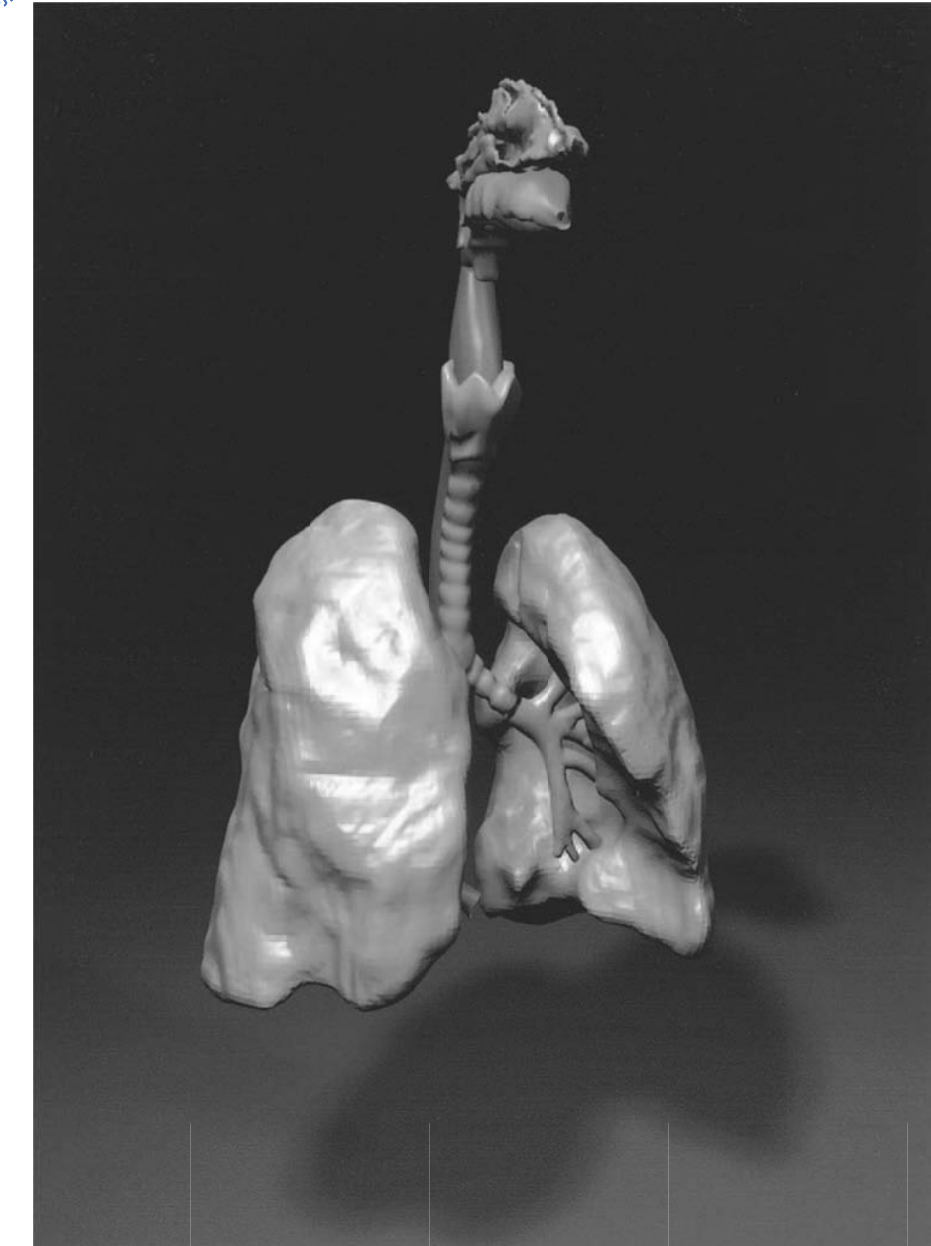
Fig. 1 Three-dimensional computer reconstruction of the entire human respiratory system. With permission